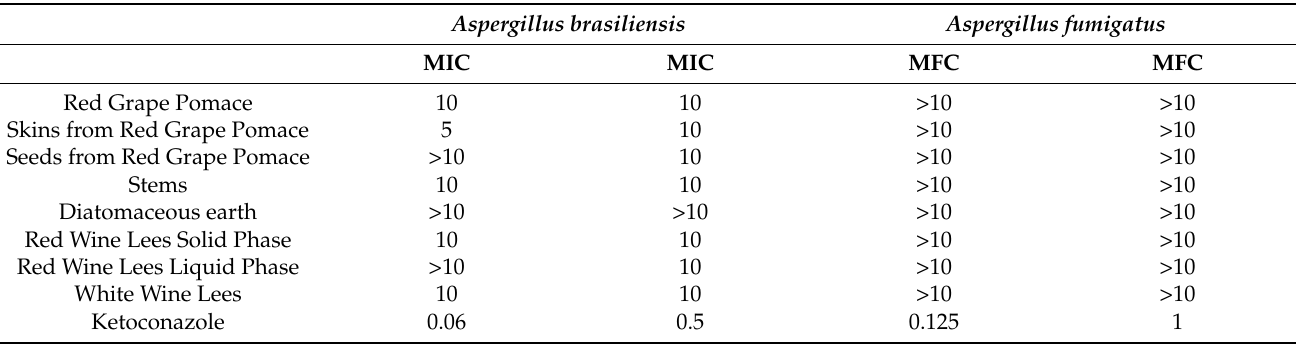
Table 5. Antifungal activity of hydroethanolic extracts (mg/mL) obtained from winemaking residues from the harvest of